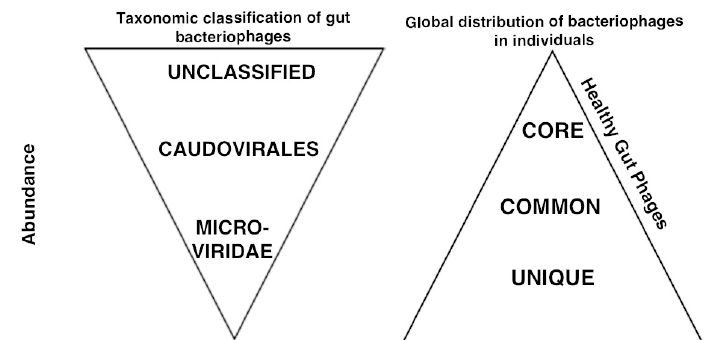
Figure 4. Bacteriophages in adult healthy individuals. The bacteriophage community of adult individuals is composed of members of the Caudovirales order, the Microviridae family and a large fraction of unclassified phages. Healthy individuals contained a relatively unique phageome and a set of shared phages between individuals that is globally distributed (<5% of total phageome). This set of shared phages has been correlated with health and proposed as the healthy gut phageome (HGP).